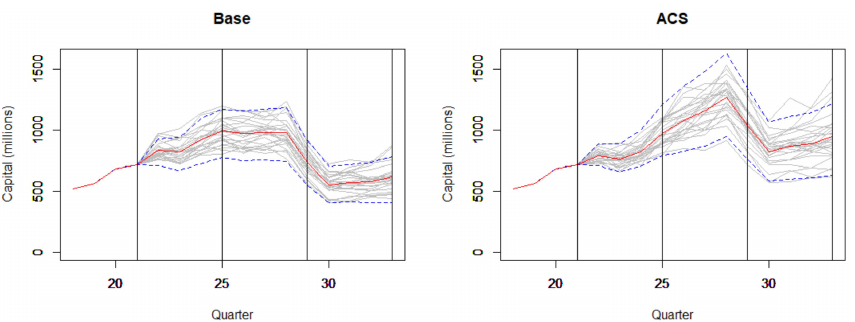
Figure 3. One- and two-year nonCPBP sample paths for the base and ACS economic scenarios. The mean path is shown in red, and 95% symmetric confidence bounds are shown in blue. The vertical lines are set at prediction inception (quarter 21) and at the 1- and 2-year future predictions (quarters 25 and 29,